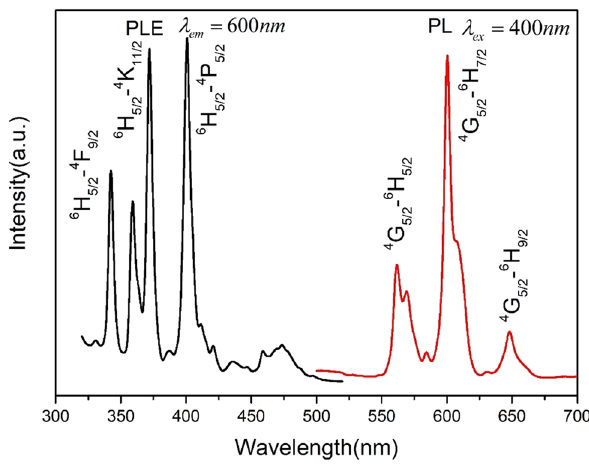
Figure 6: PLE andPLspectra ofKBP:0.12Sm 3 + phosphors ( λ em = 600nm, λ = 400nm ) ex